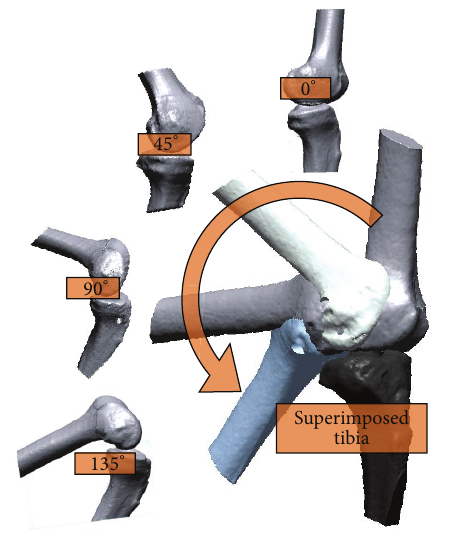
( 𝑥 -, 𝑦 -, and 𝑧 -axes and pitch, roll, and yaw) were fixed. In the second step, a sequential movement of femoral flexion was reproduced using femur models at different angles (0, 45, 90, and 135 degrees) based on the fixed tibia. The